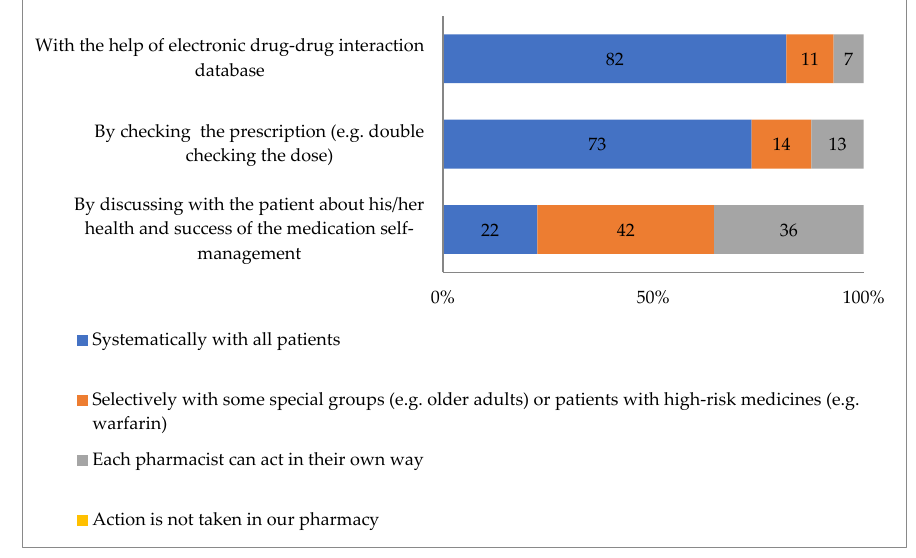
Figure 4. Actions taken to identify medication-related risks in routine dispensing in community pharmacies ( n = 169).